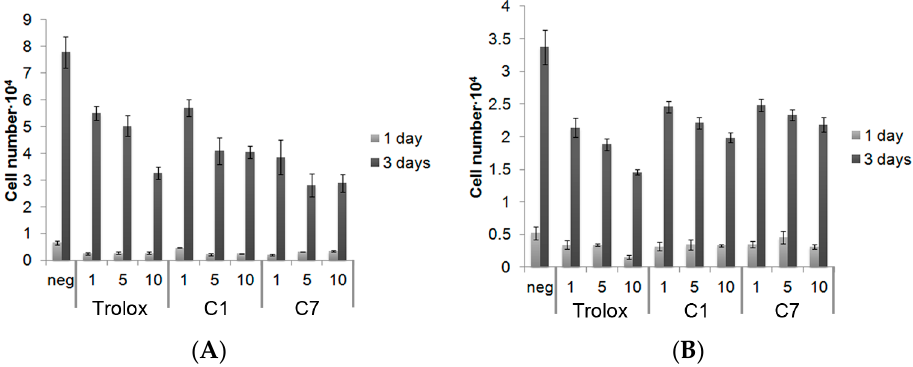
Figure 3. Viability of ( A ) RAW264.7 cells and ( B ) THP-1 cells after exposure to Trolox, C1, and C7 at different concentrations (1, 5, and 10 µM) (normalized to positive control). Values expressed as mean ± standard deviation.